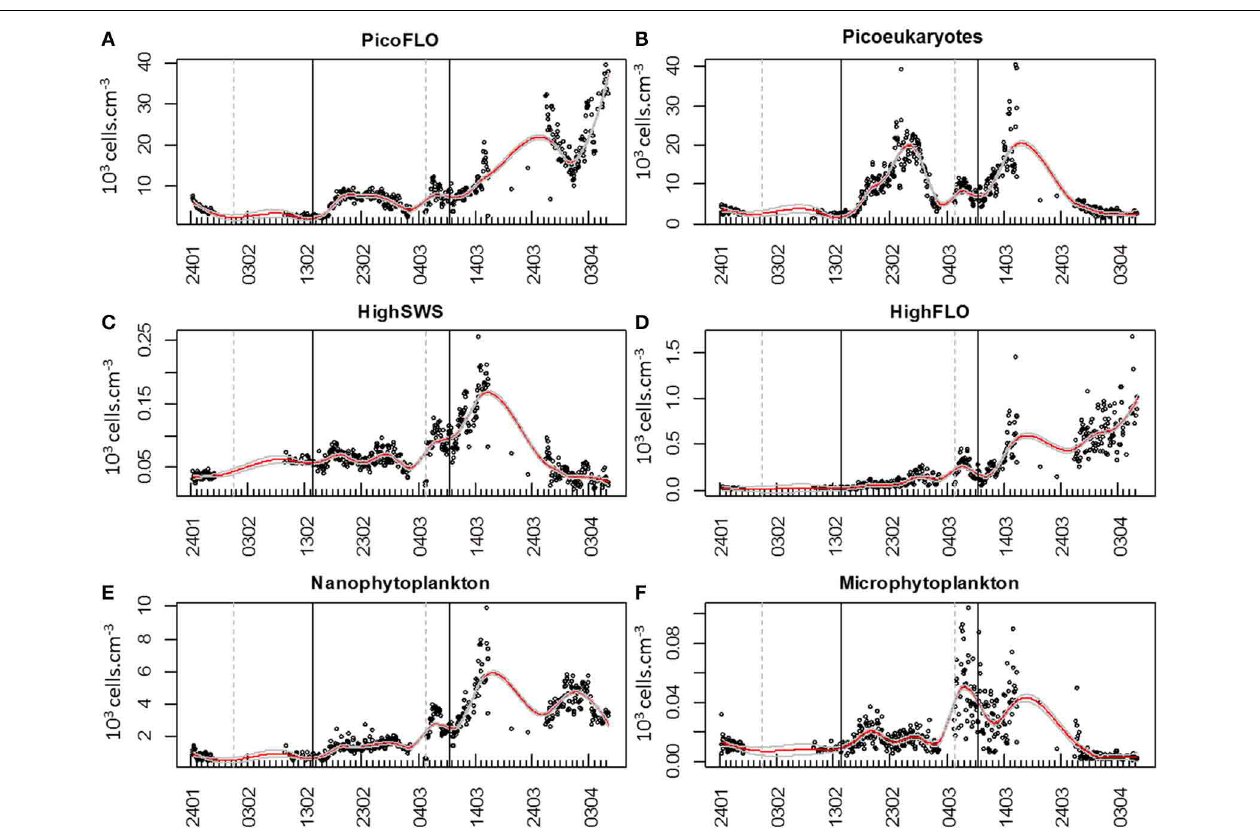
FIGURE 5 | Dynamics of cell abundances as determined with CytoBuoy’s instrument for each resolved cluster. The gray vertical dashed lines materialize the two main precipitation events ( Figure 2E ) and the black vertical lines the two main NO − 3 + NO − 2 pulses ( Figure 2A ). Continuous red lines represent the applied loess to the time series, with its standard error